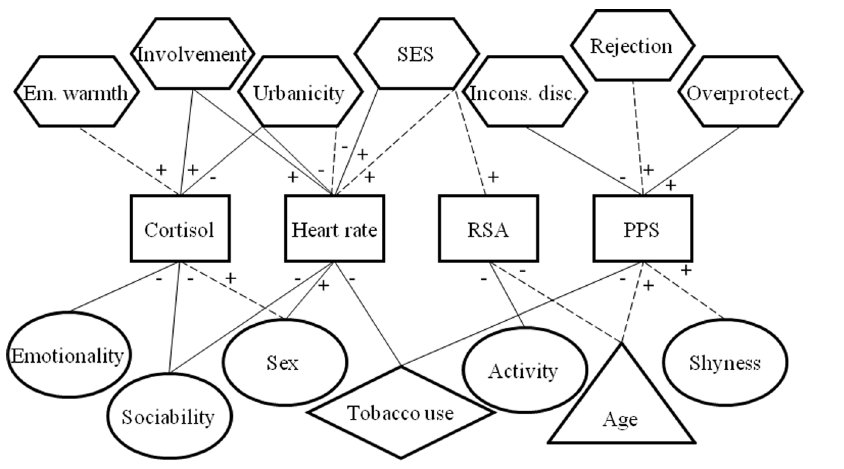
Figure 3. Schematic description of significant determinants of the four indices of the stress response. Notes. Em.=emotional; SES=socioeconomic status; Incons. disc.=inconsistent discipline; RSA=respiratory sinus arrhythmia; PPS=perceived physiological stress; square outlines pertain to stress responses; circles pertain to individual factors; triangles pertain to developmental factors; hexagons pertain to environmental factors; diamonds pertain to substance use- related factors; dotted connecting lines pertain to children; solid connecting lines pertain to adolescents.